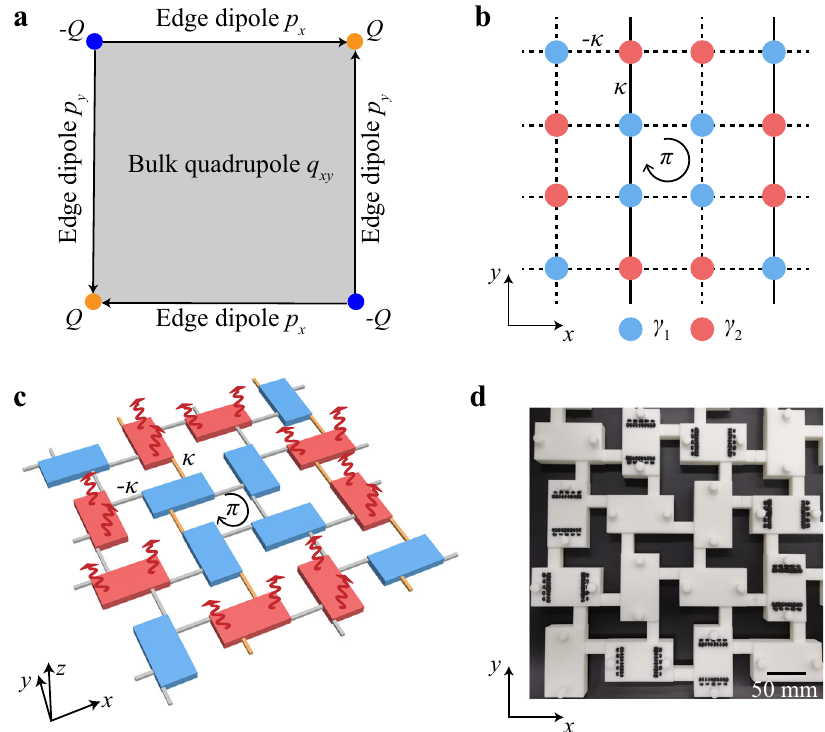
Fig. 1 Non-Hermiticity-induced quadrupole topological insulator and its acoustic implementation. a Schematic of a bulk quadrupole moment ( q xy ) with its accompanying edge dipole moments ( p x and p y ) and corner charges ( Q ). b Tight-binding model of a unit cell that consists of 16 sites. Red (blue) sites have an imaginary on-site potential of γ 2 ( γ 1 ). Solid (dashed) lines denote positive (negative) couplings with strength κ . There is a π fl ux threading each plaquette due to the negative couplings. c Acoustic design of the lattice model in ( b ). Blue and red cuboids represent acoustic resonators with only background loss ( γ 1 ) and those with deliberately enhanced loss ( γ 2 ), respectively. These resonators are coupled by identical thin waveguides. The coupling waveguides that exhibit positive (negative) couplings are colored in yellow (gray). d Photo of the fabricated sample that realizes the acoustic lattice shown in ( c ). Some resonators have small holes sealed with black absorbing materials to enhance the